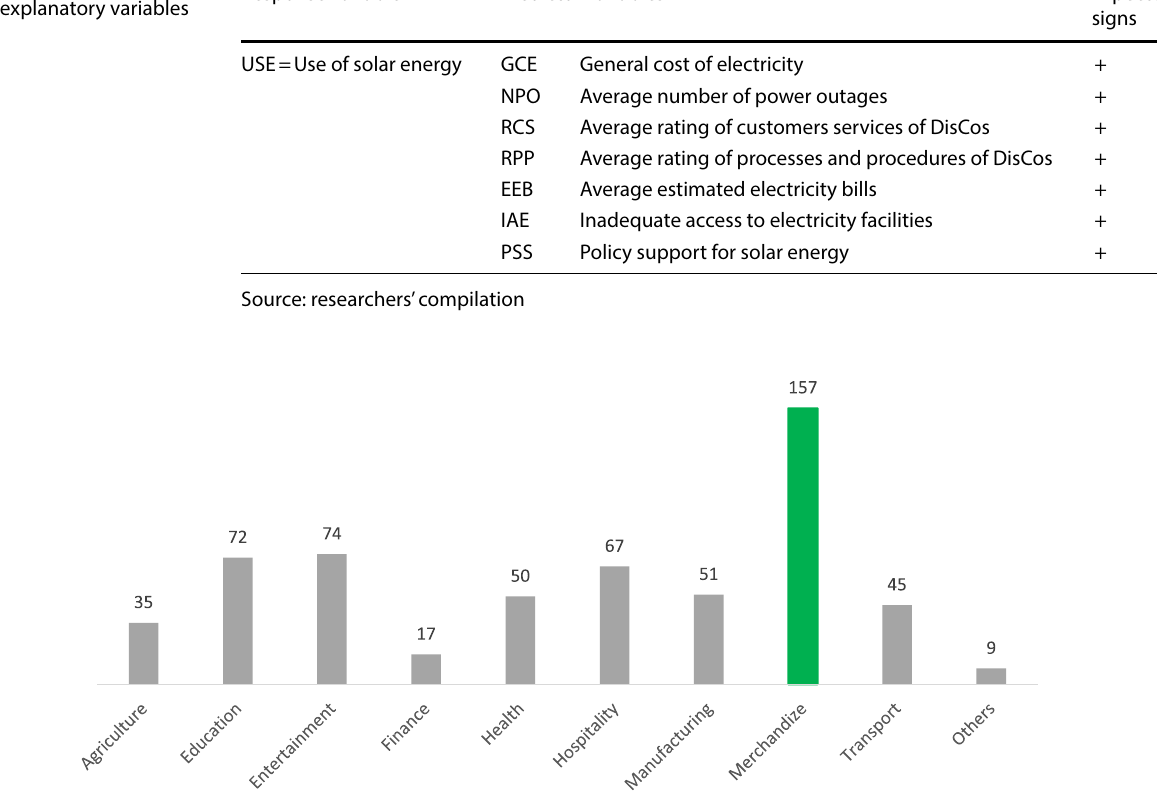
Table 2 A priori expectation of the explanatory variables